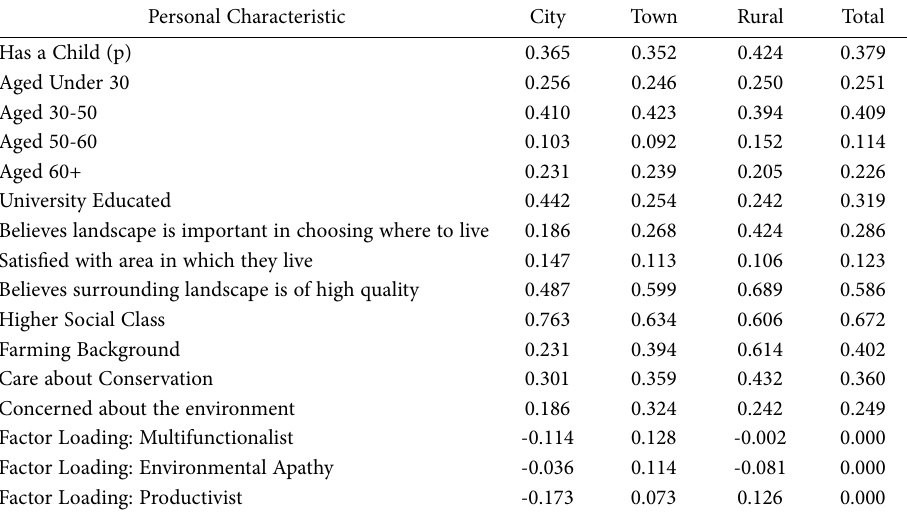
Table 5. Summary Statistics of Personal Characteristics and Environmental Preferences used as Taste